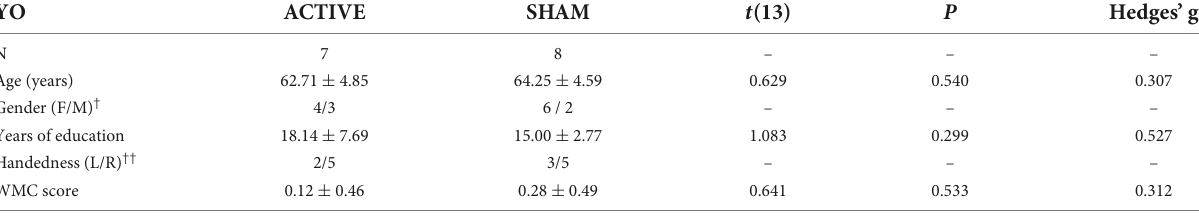
TABLE 2 Demographic and baseline characteristics of the sample divided by AGE, for each STIMULATION group. YO